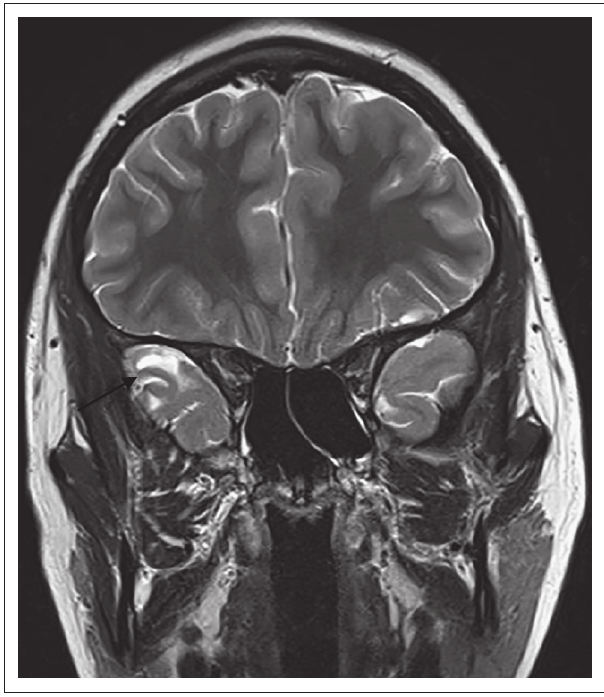
FIGURE 9: An 8-year-old girl with drug-resistant epilepsy since age 2. Axial T2W demonstrates cystic encephalomalacia in the left middle cerebral artery territory related to remote infarction involving the left temporal lobe, insula, left frontal and parietal regions. Note ex vacuo dilatation of the left lateral ventricle (arrow), Wallerian degeneration of the cerebral peduncle and encephalomalacia of the left thalamus.